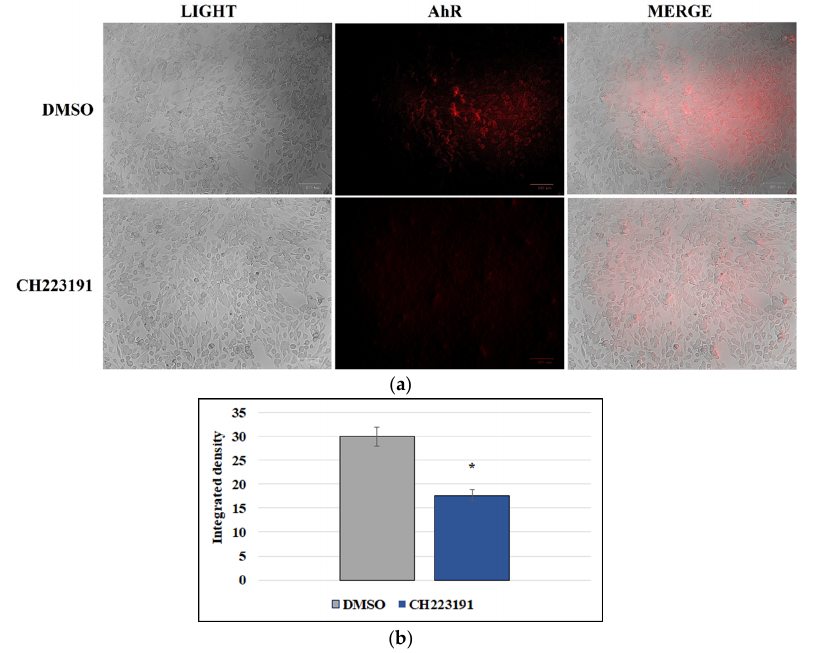
Figure 4. A72 cells express AhR. ( a ) Canine fibrosarcoma cell line A72 expressed AhR. AhR inhibitor CH223191 noticeably decreased the expression of AhR. Scale bar 100 μ m. ( b ) Bars represent the mean ratio generated from the integrated density (product of the area and mean intensity of fluorescence) of the AhR expression evaluated by ImageJ. Error bars represent standard deviation measurement. Significant differences between CCoV-infected cells and AhR-inhibitor-treated infected cells are indicated by probability p . * p < 0.05.